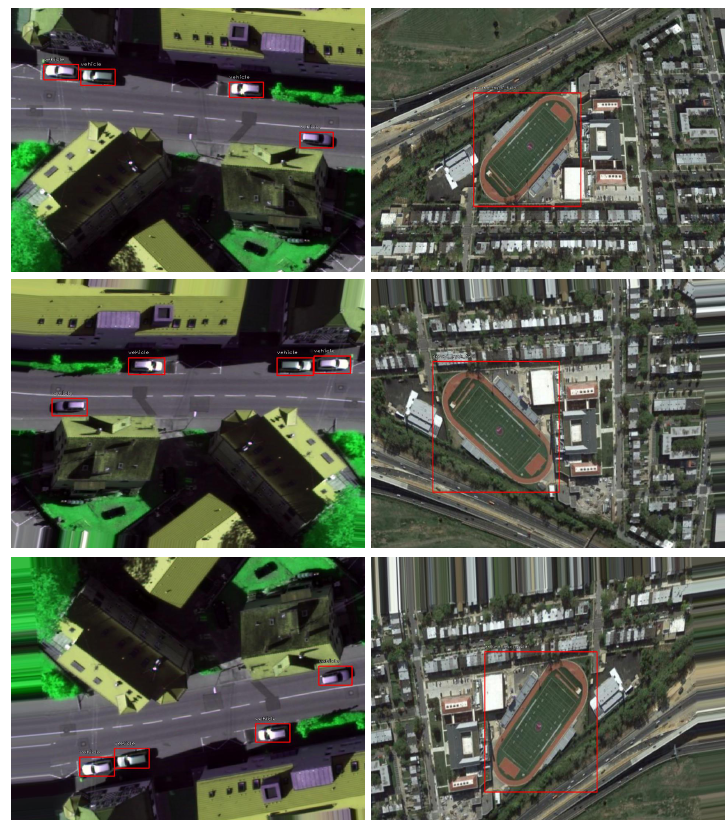
Figure 5. Examples of data augmentation technique. First row represents the input images while the second and third rows represent the augmented